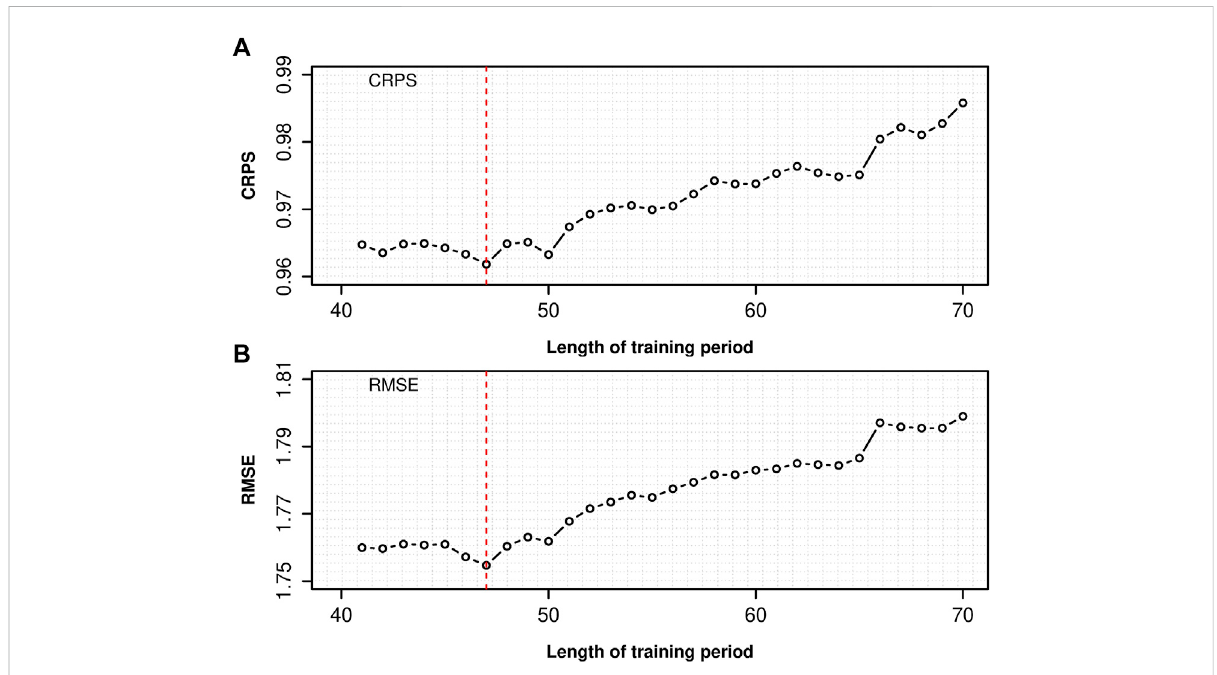
FIGURE 2 Veri fi cation metrics of (A) CRPS score and (B) RMSE with different training period lengths for the BMA forecast.